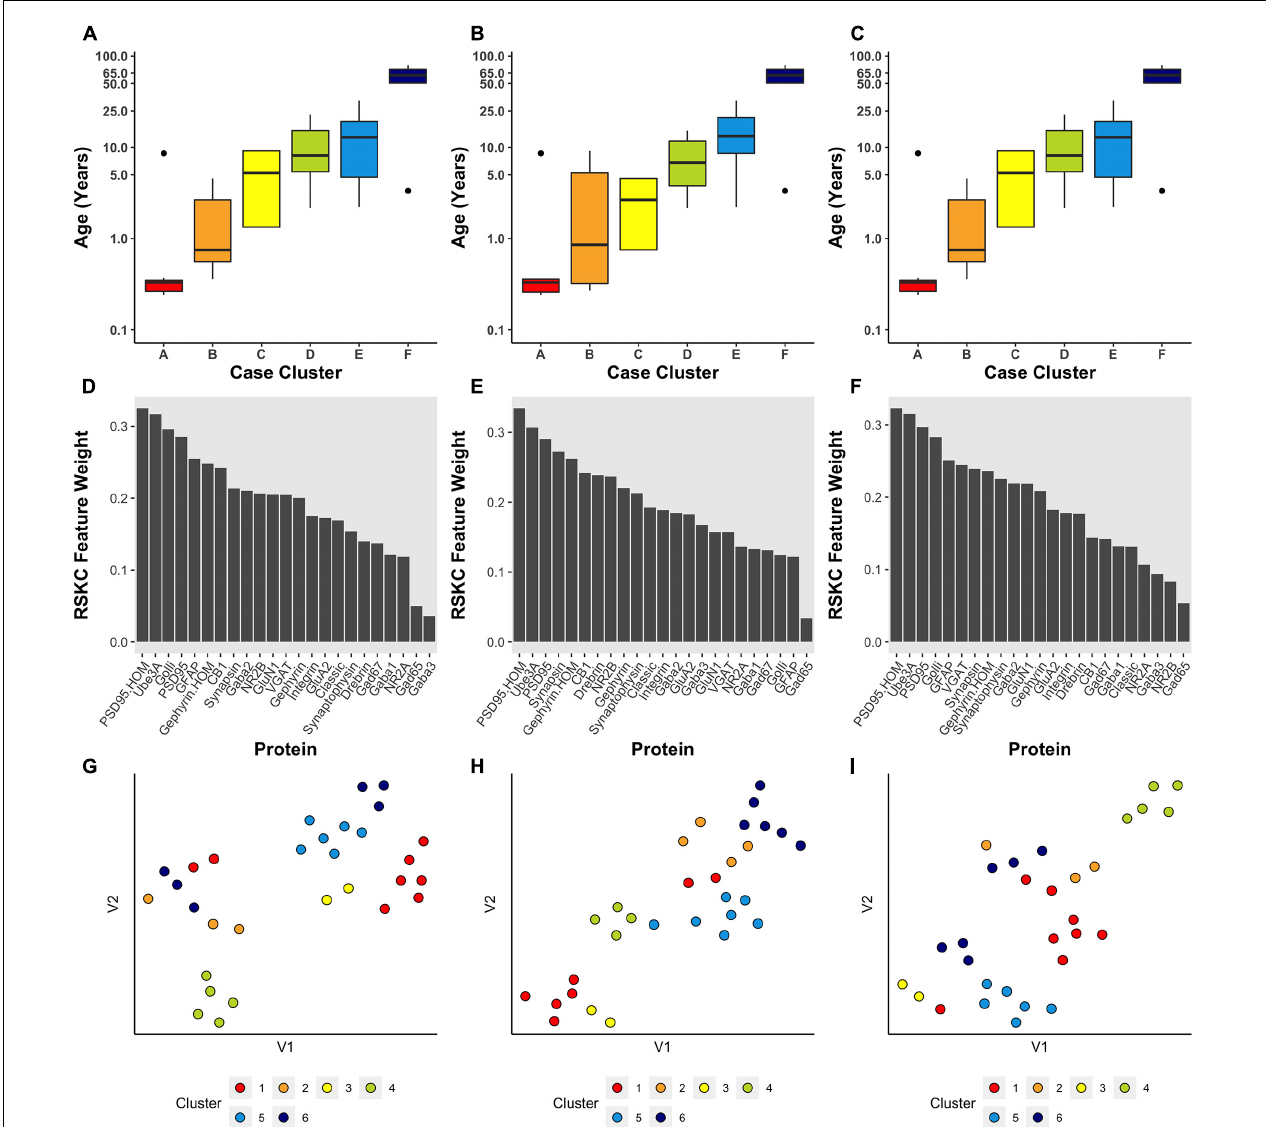
FIGURE 5 | Age-related clustering of 23 synaptic proteins for three single iterations. (A–C) Expression data from 23 synaptic proteins was used to identify six case clusters. Boxplots of cluster age ordered from youngest (red) to oldest (dark blue) median age. (D–F) Bar plot visualizing RSKC feature weights for proteins. (G–I) tSNE plot of the protein data scaled by RSKC weights and color-coded by RSKC cluster. In both (A–C) and (G–I) , sample ages were reduced to sample averages to reduce